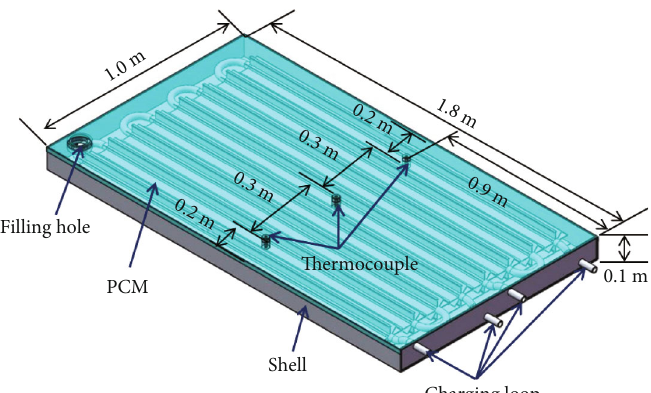
Figure 1: The structural view of a TES plate.